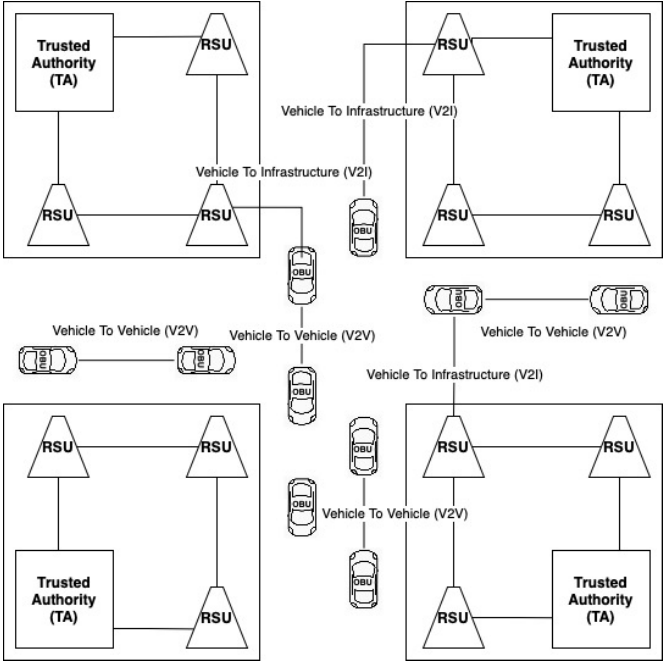
Figure 1. The idea of VANET network